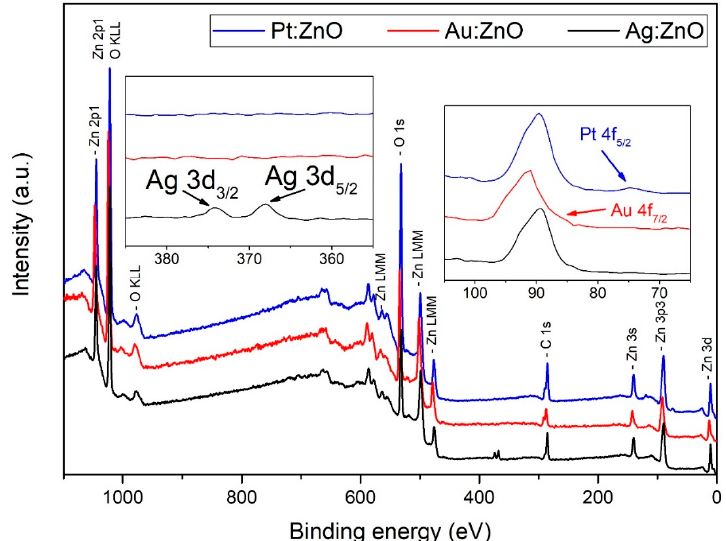
Figure 7. Wide XPS spectra of ZnO nanoparticles doped with Ag (black), Au (red), and Pt (blue). In insets: identification of Ag, Au, and Pt.